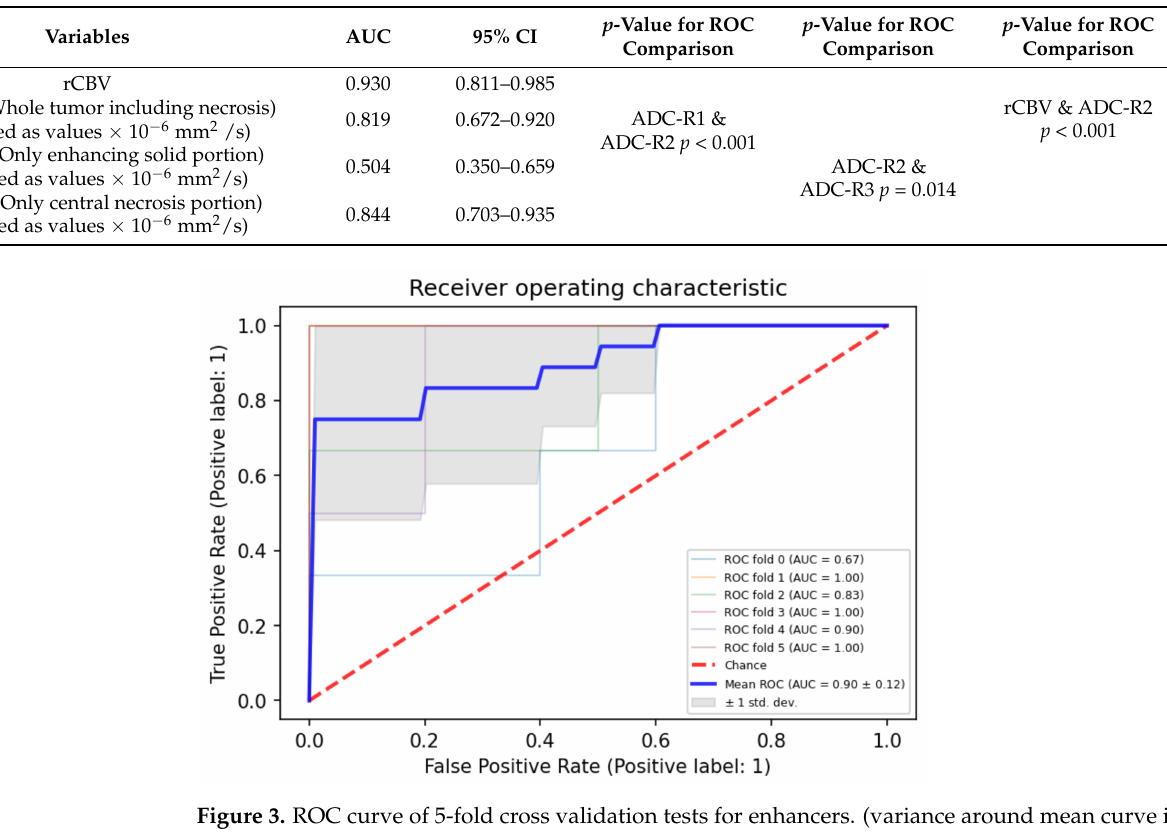
Table 3. Comparison of ROC curves for both readings of all lesions with statistical p values.